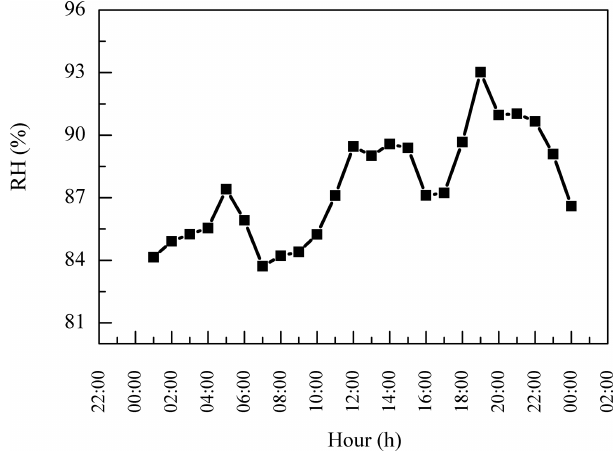
Figure 6. Average diurnal variation of RH during the sampling pe- riod at the top of Mt. Tai.